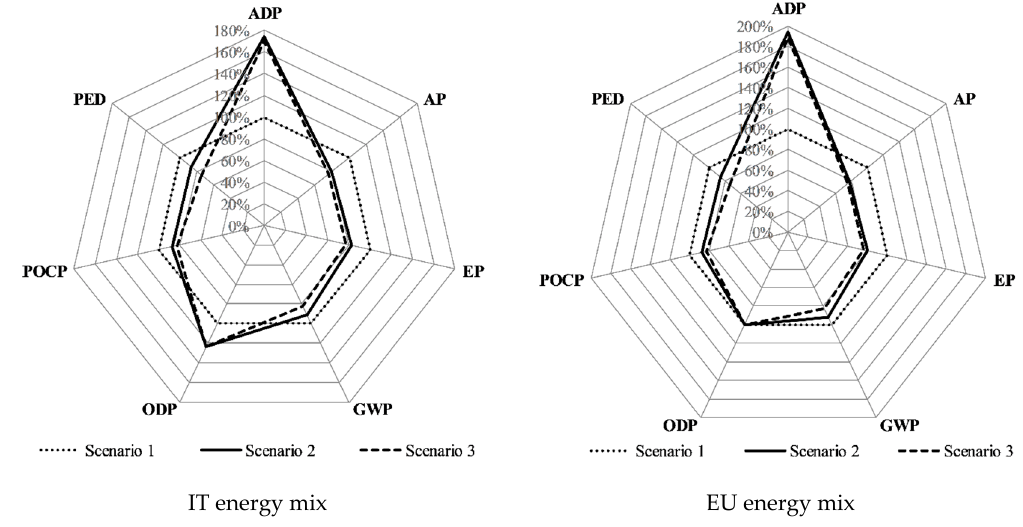
Figure 12. Impact categories about the first scenario with EU-27 and Italian mix.